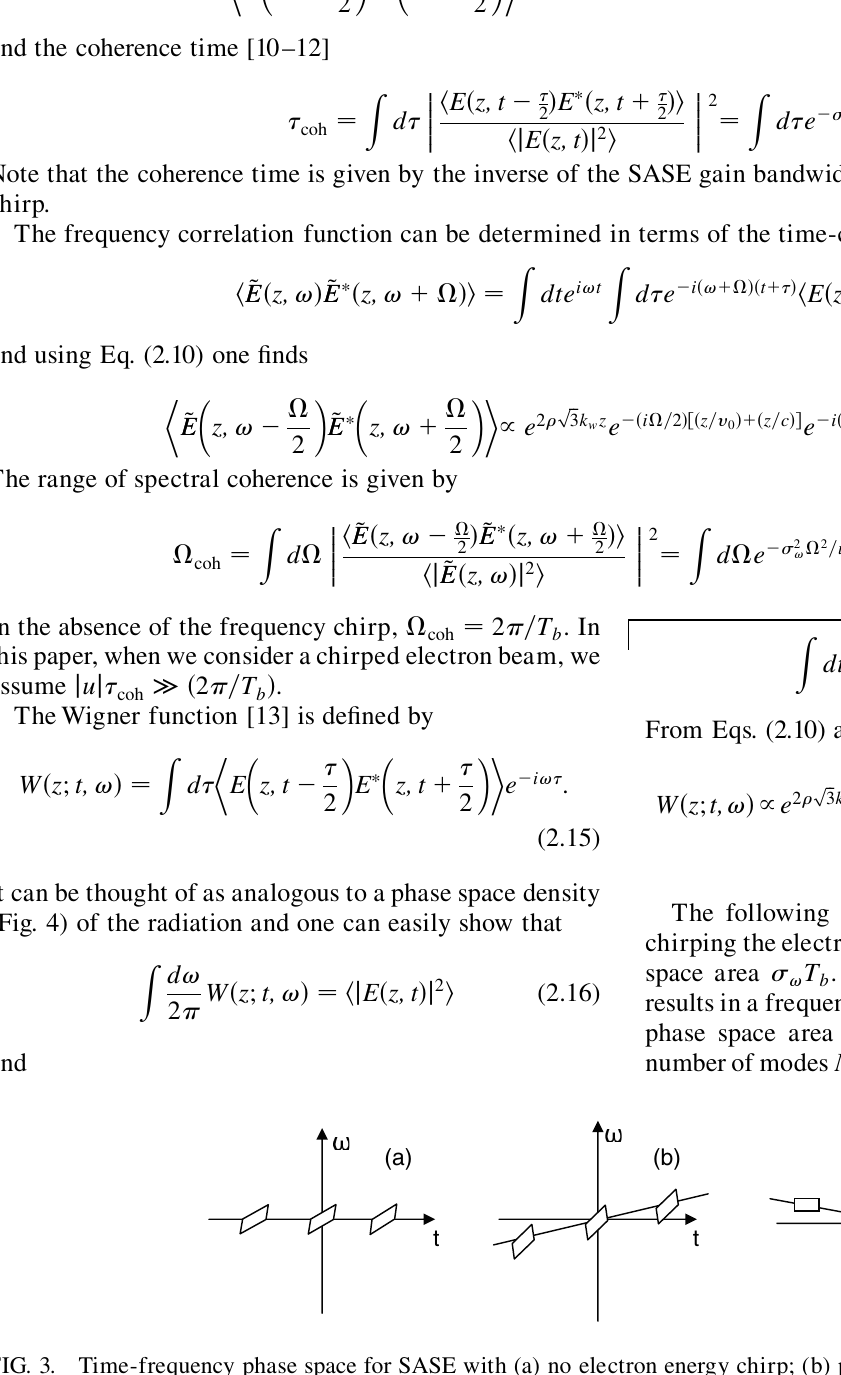
FIG. 3. Time-frequency phase space for SASE with (a) no electron energy chirp; (b) positive electron energy chirp; (c) negative energy electron chirp chosen to cancel intrinsic SASE frequency chirp as in Ref. [7]. The little rectangles represent the wave packets associated with three representative